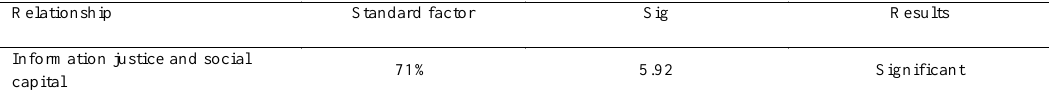
Table 3: Results of structural model